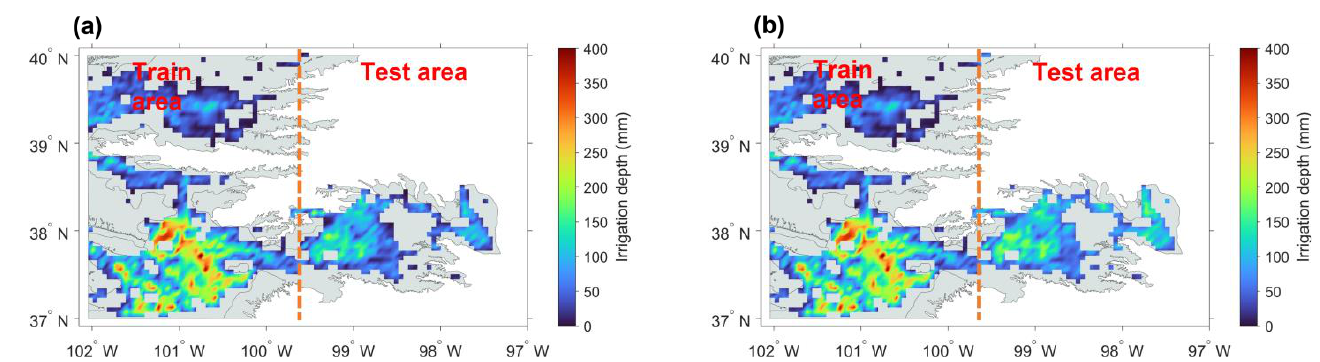
Figure 6. Spatial distribution of ( a ) in situ and ( b ) RFR estimated irrigation amounts in Experiment B (spatial split) for a medium model performance year (2011). The red dashed line divides the training (western) and test (eastern) portions.